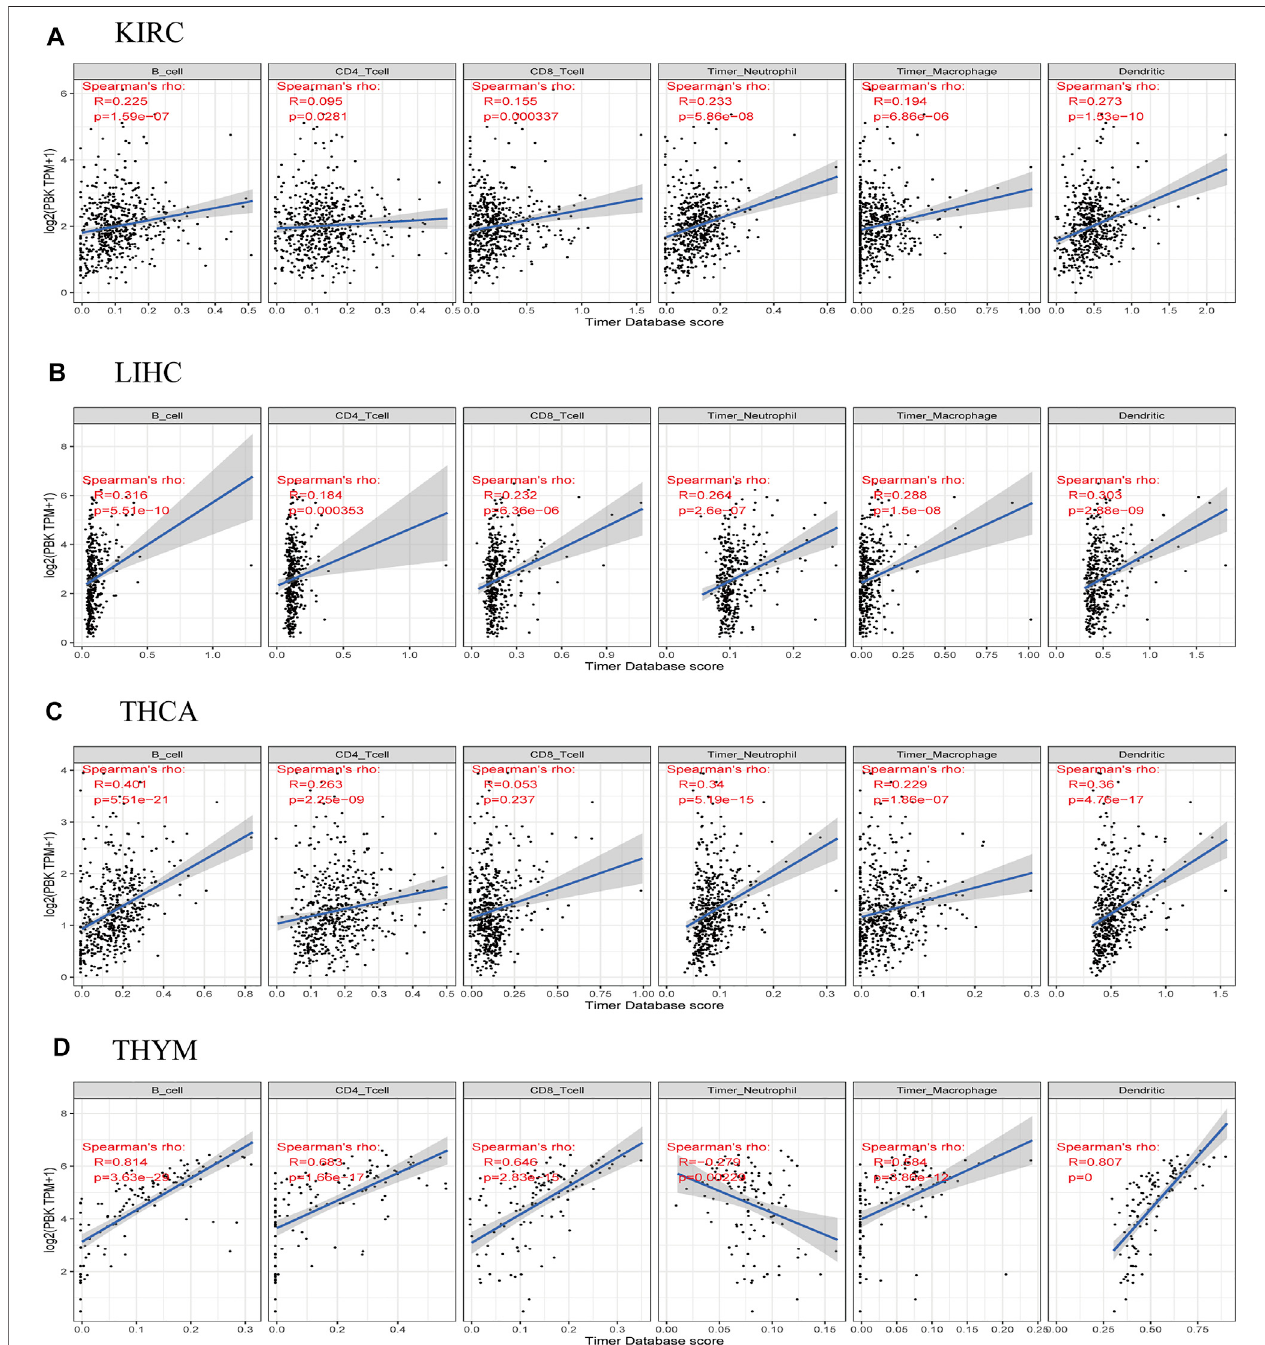
FIGURE 6 | Correlations between PBK expression and immune cell in fi ltration in cancers. (A) KIRC. (B) LIHC. (C) THCA. (D) THYM.